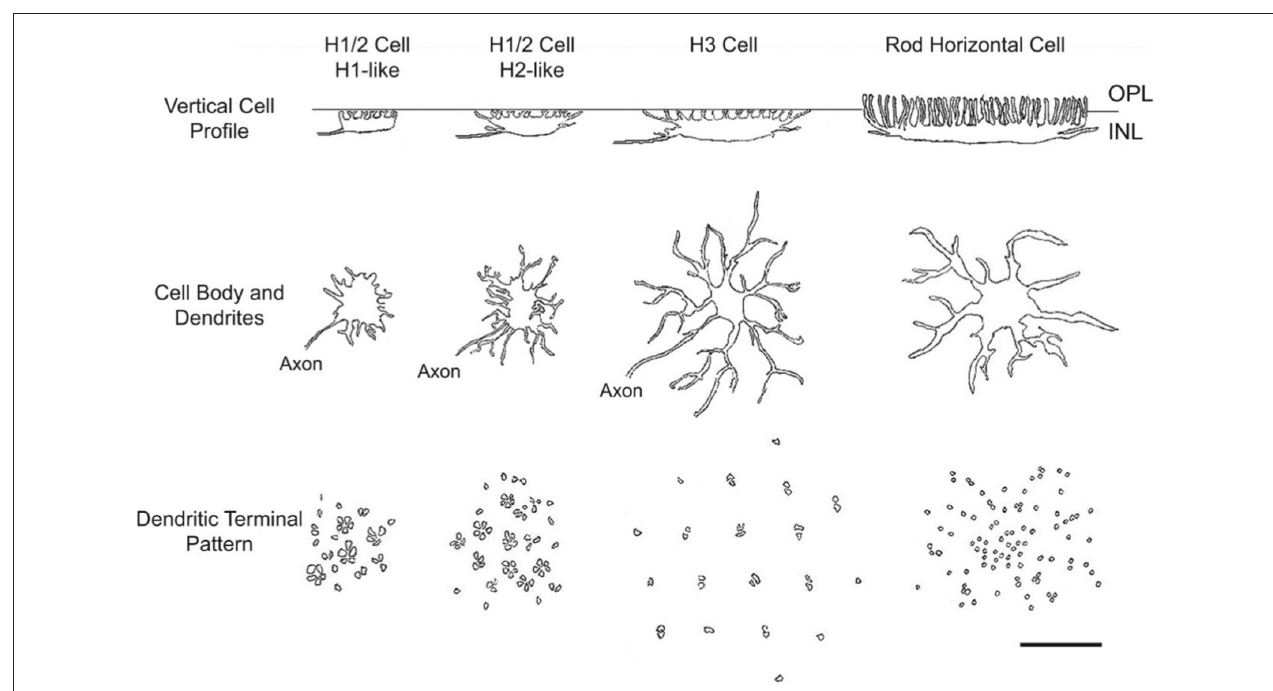
FIGURE 2 | Zebrafish horizontal cells (HCs). HCs in zebrafish retina are morphologically distinct. H1-like cells are smaller in vertical profile and somal size compared to H2 and H3 cells, and all types have distinct dendritic connections with presynaptic photoreceptors (PRs). Reproduced with permission from Song et al. (2008).